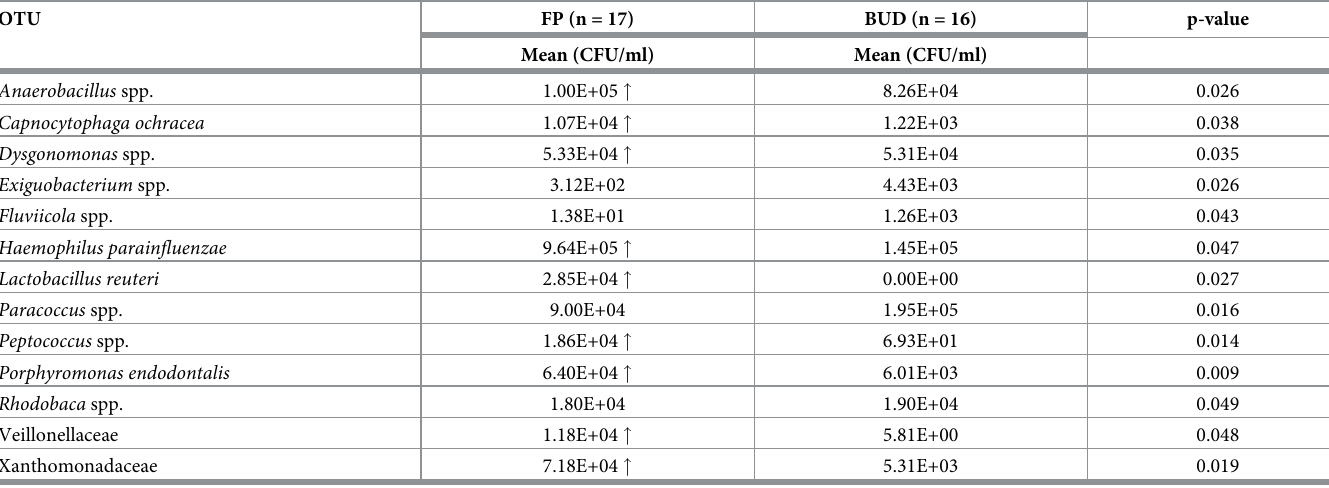
Table 5. OTU changes between type of ICS in the high-dose ICS group.